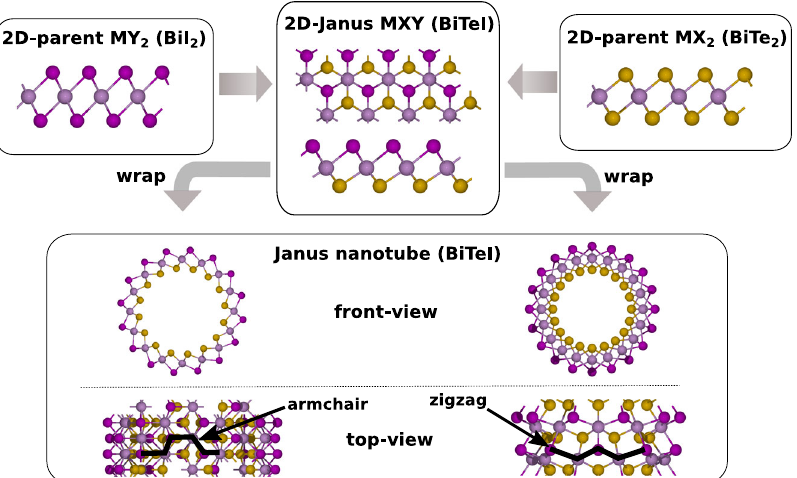
Fig. 1 Basic principle of the computational work fl ow. The symmetric MY 2 and MX 2 are the parent sheets for the asymmetric 2D Janus MXY sheet, which can be wrapped up to form a 1D Janus nanotube. In this case M = Bi (light purple), X = Te (dark yellow), and Y = I (dark purple).